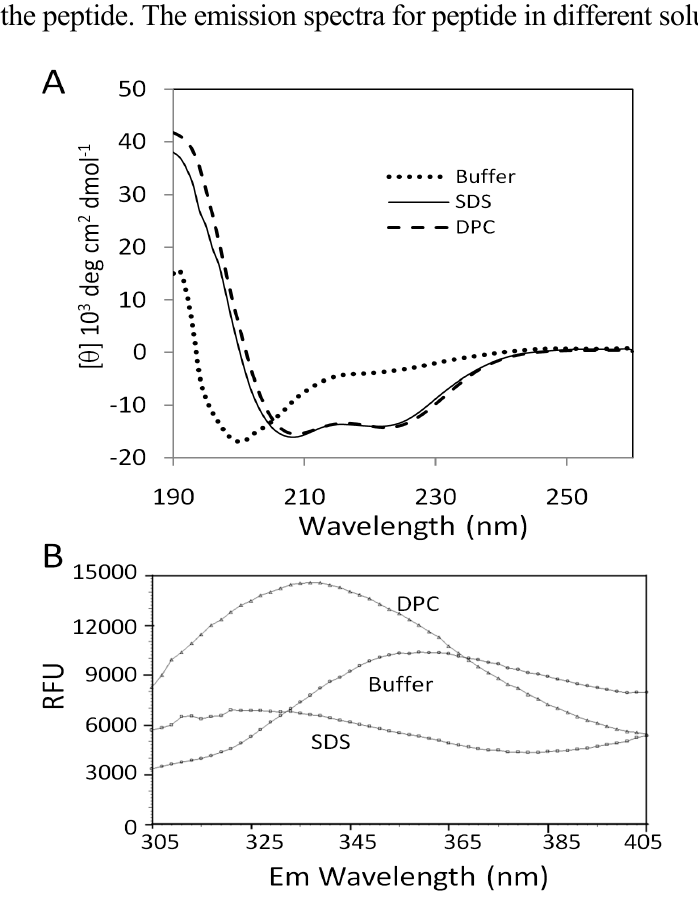
Figure 2. Effect of solvent systems on the peptide structure. ( A ) CD spectra of the peptide in different solutions. The CD spectra of the peptide in an aqueous solution, DPC and SDS micelles are shown with dotted, dashed and solid lines, respectively. ( B ) Fluorescence spectroscopy for the peptide. The emission spectra for peptide in different solutions are